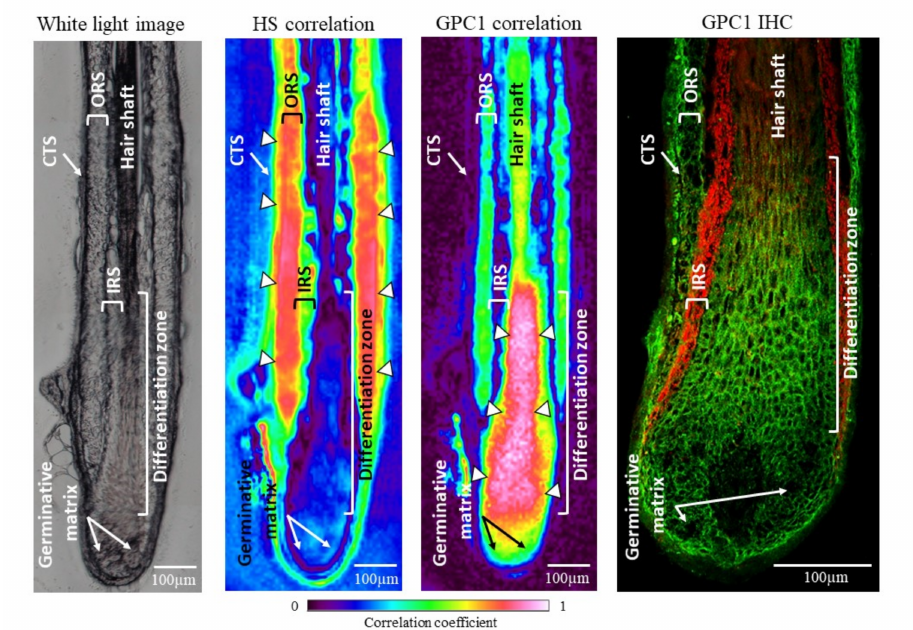
Figure 3. Characterization of hair follicle structures by different imaging approaches. From left to right: white light image, HS- and GPC1-correlated IR images, and immunohistochemical labeling of GPC1 (green) counterstained with the Evans blue dye (red). CTS, connective tissue sheath; IRS, inner root sheath; ORS, outer root sheath. Arrowheads indicate high level of correlation. Scale bar: 100 µ